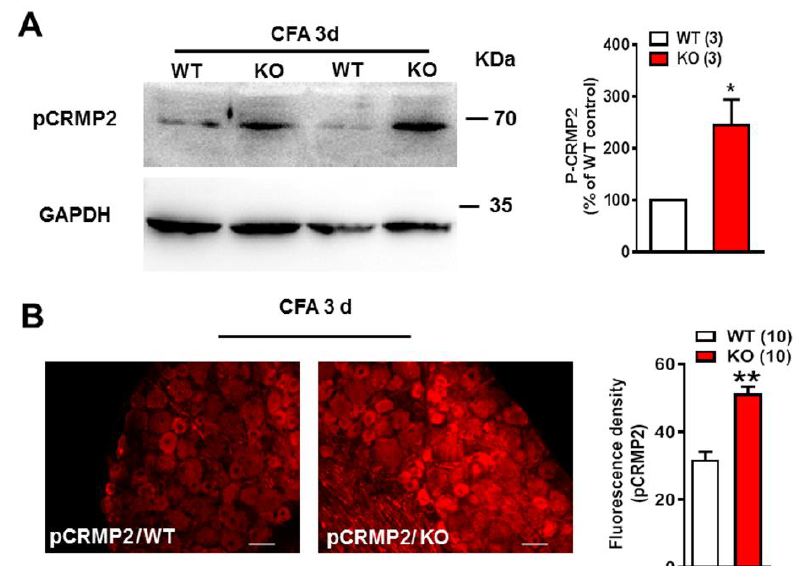
Figure 3. Nogo-A inhibited the expression of pCRMP2 in DRG of rats with CFA injection. ( A ) Compared with the WT, KO of Nogo-A increased the expression of pCRMP2 in rat DRG 3 days after CFA injection. * p < 0.05, unpaired t -test, n = 3. ( B ) The fluorescence density of pCRMP2 was obviously increased in DRG of Nogo-A KO rat after CFA 3 d, compared with WT. ** p < 0.01, unpaired t -test, n = 10. The scale bar is 50 μ m. Data are expressed as mean ± SEM.